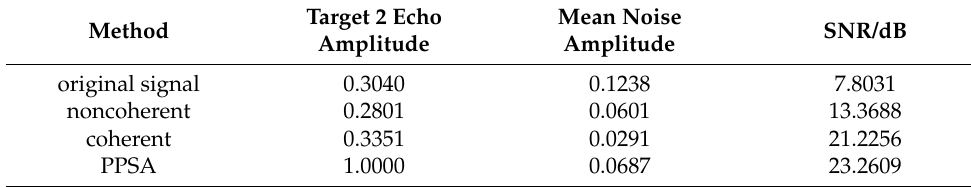
Table 6. SNR comparison of target